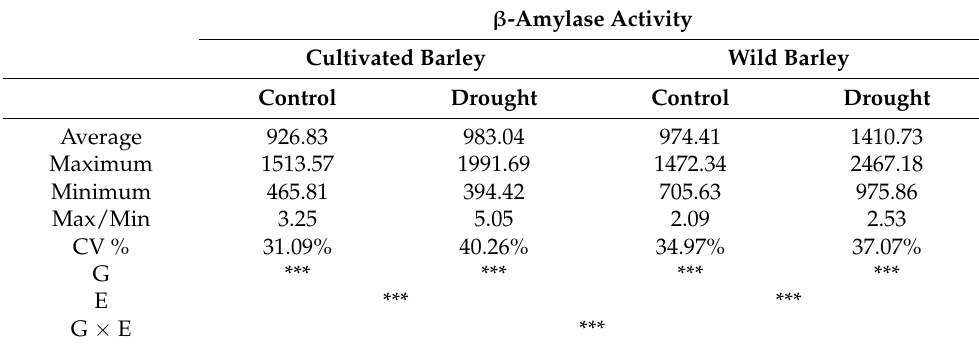
Table 4. The distribution of the grain β -amylase activity of Bmy1.a alleles.